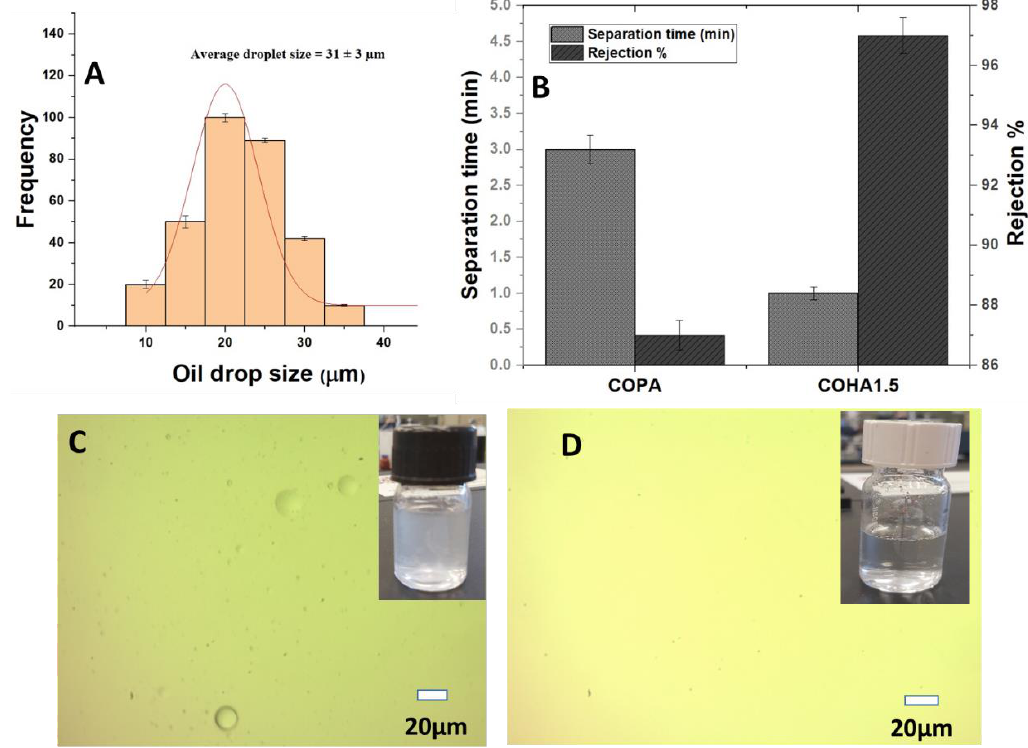
Figure 8. ( A ) Size distribution curve of oil/water emulsion. ( B ) Oil/water emulsion separation of copolyamide composite mats. ( C ) Optical microscopy image of 100 ppm emulsion before filtration. ( D ) Permeate of 100 ppm emulsion with inset digital image.